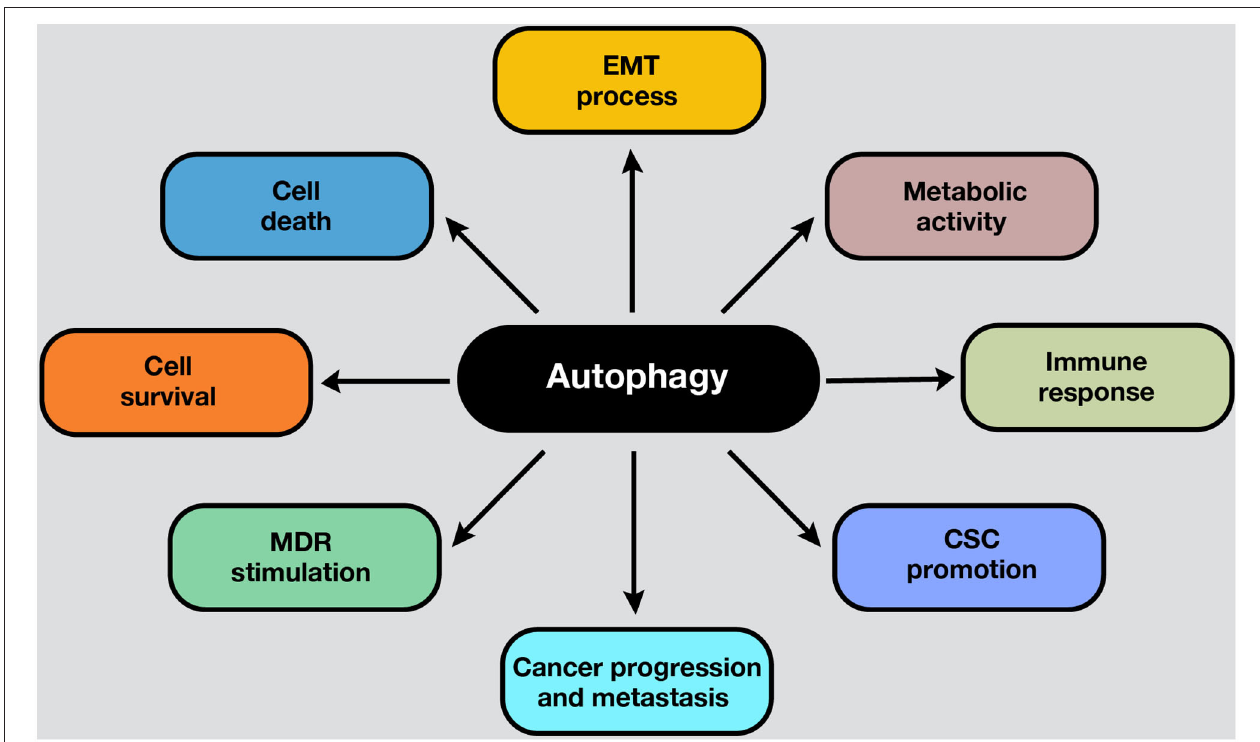
FIGURE 1 | Roles of autophagy in cancer. Autophagy mechanisms are involved in several hallmarks in cancer cells. Autophagy can lead to cell survival or death, depending on the presence, duration, and intensity of the stimulus in which it develops. In addition, autophagy can modulate the EMT phenotype after the adaptation to hypoxia. Moreover, the metabolic switch of cancer cells into aerobic glycolysis (i.e., the Warburg effect) is sustained by autophagy activation, ensuring energetic requirements, and metabolic homeostasis. On the other hand, the activation of autophagy process influences the suppression or activation of antitumor immune response, depending on the stage, genetic, and microenvironmental conditions. For example, in response to chemotherapy, autophagy-competent cancer cells attracted dendritic cells, and T lymphocytes to the tumor, activating the immune response. Moreover, autophagy activation maintains the CSC phenotype and functions inside the tumor. Also, an upregulated autophagic activity are involved in cancer progression and metastasis. Furthermore, autophagic machinery triggered by anticancer drugs may facilitate multiple drug resistance in cancer cells and tumor survival. All these processes depend on the cell type, genetic background, and the microenvironment stimulus in the